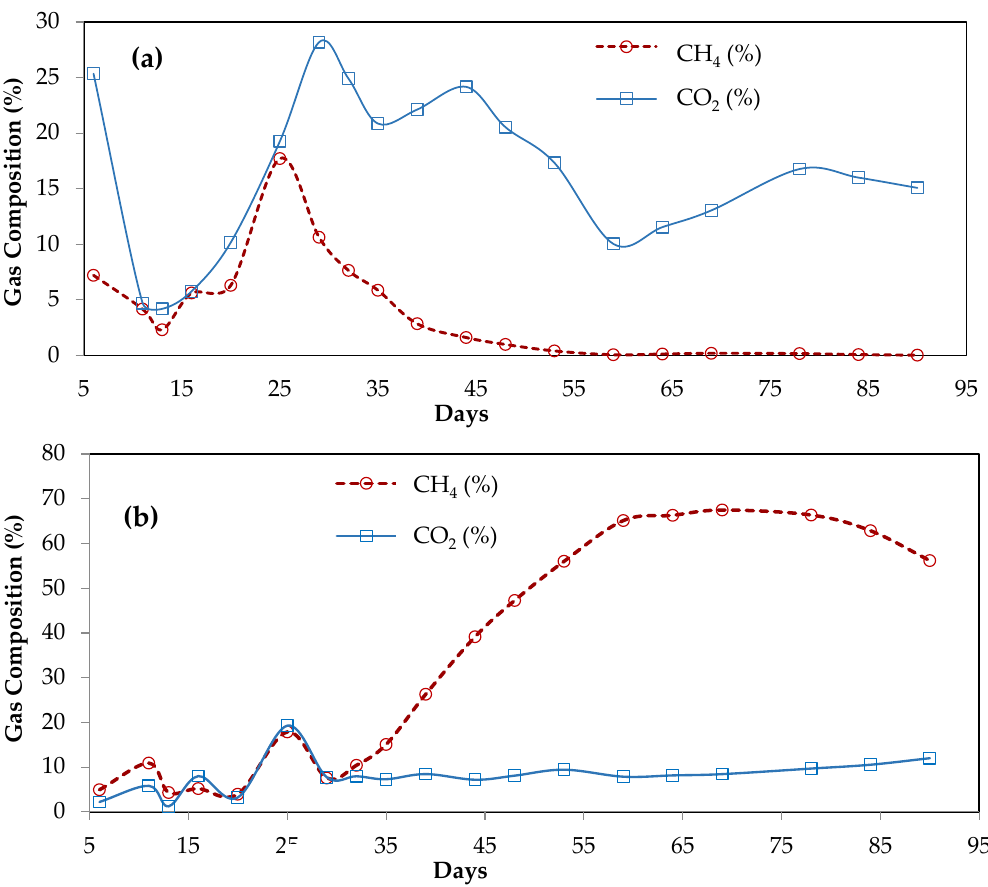
Figure 4. Composition of biogas obtained from ( a ) first and ( b ) second reactor of two-staged AD.